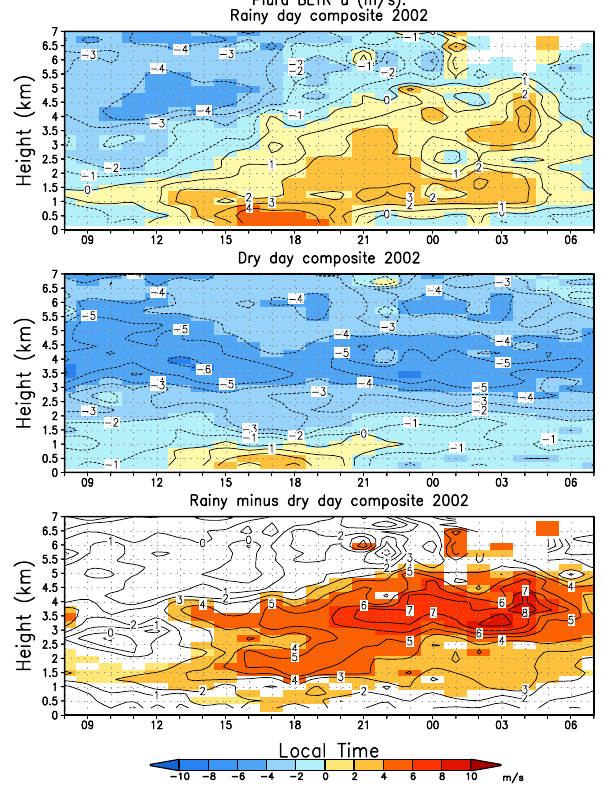
Fig. 8. Similar to Fig. 6 but for BLTR data for March–April